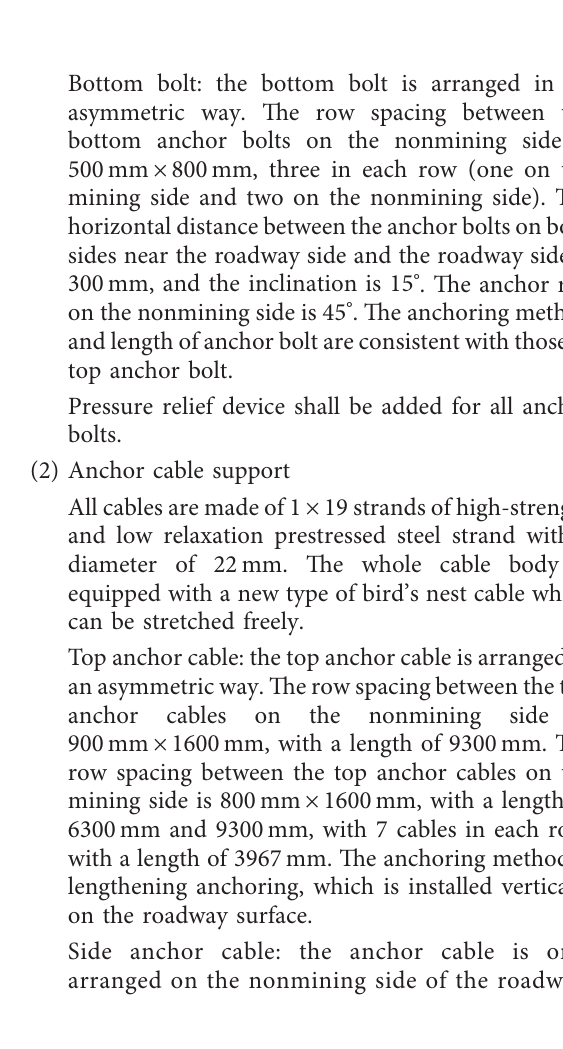
Figure 9: Schematic diagram of asymmetrical high prestress pressure relief coupling control technology: (a) before deformation; (b) after